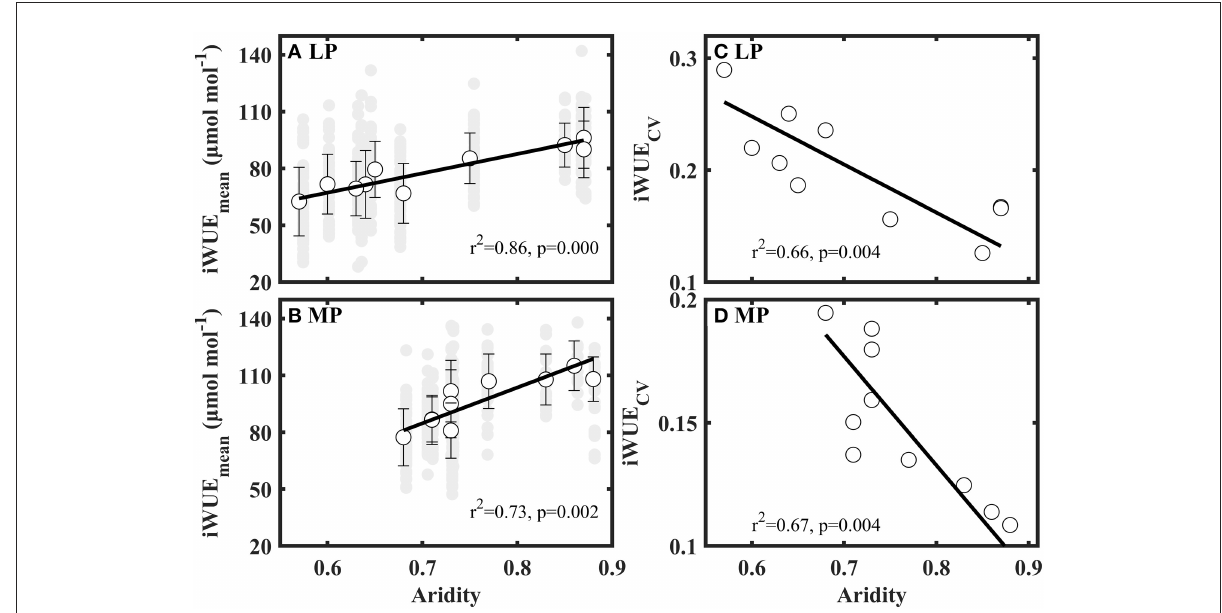
FIGURE4 Patterns of mean value (iWUE mean ) (A,B) and coefficient of variation (iWUE CV ) (C,D) of intrinsic water use efficiency (iWUE) along aridity gradients in Loess Plateau (LP) and Inner Mongola Plateau